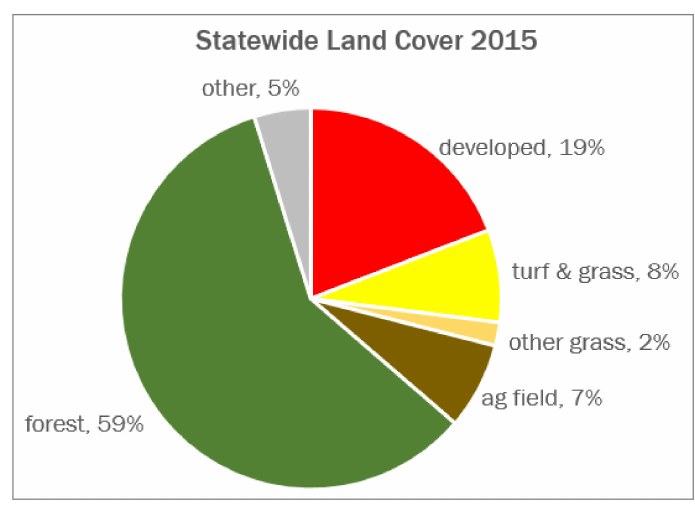
Figure 11. Breakdown of major land cover categories, statewide, 2015.